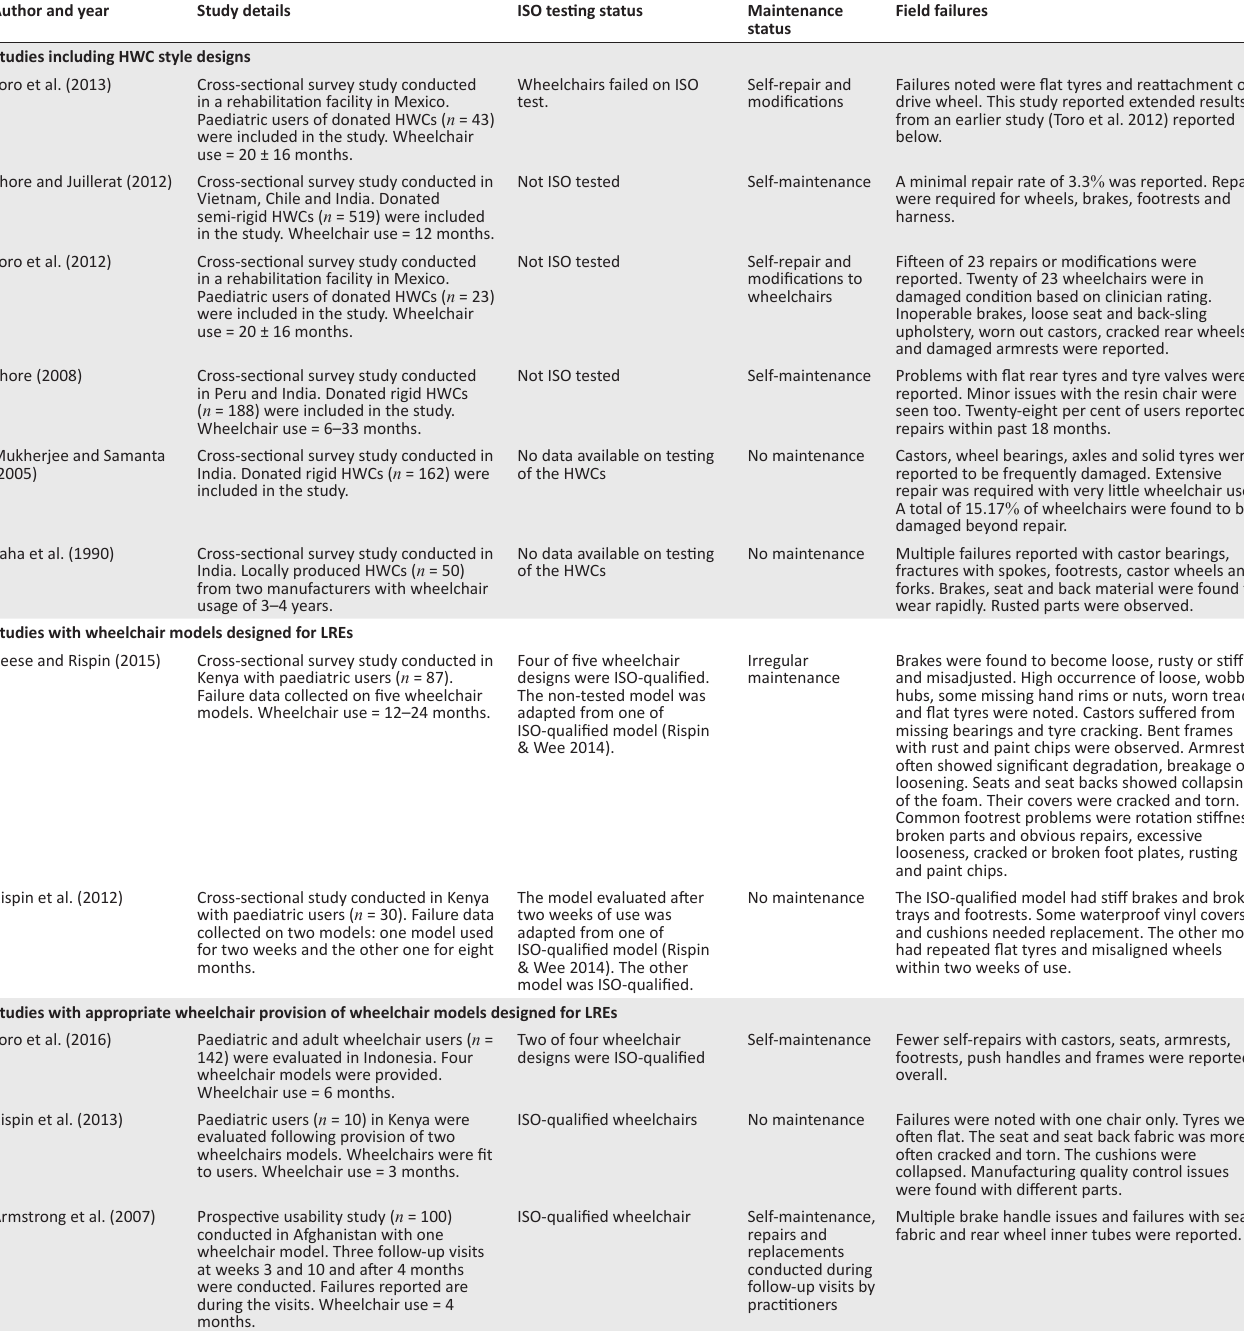
TABLE 2: Field failures of manual wheelchairs in less-resourced